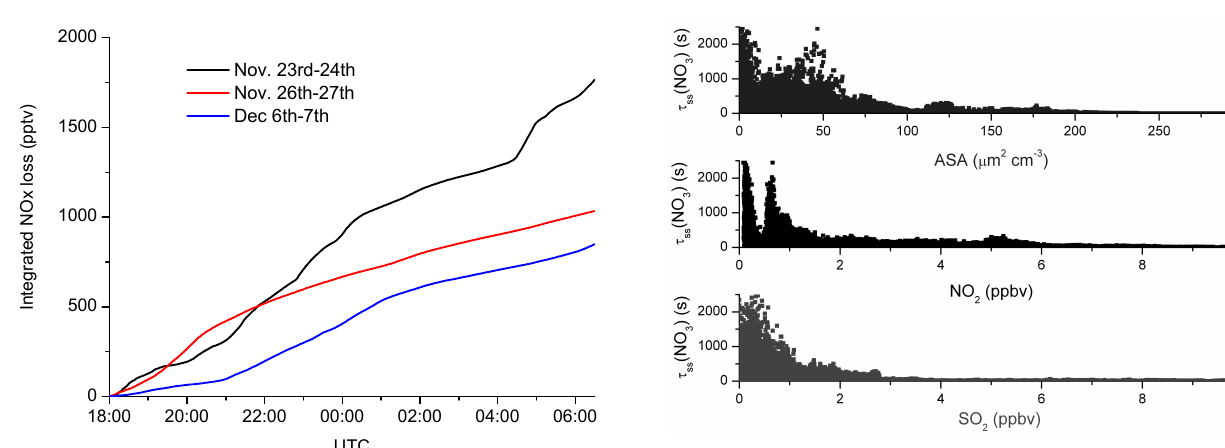
Fig. 12. Integrated loss of NO x on three campaign nights with air from the Huelva sector (black line), the continental sector (red line) and the Atlantic sector (blue line). Mean NO 2 concentrations